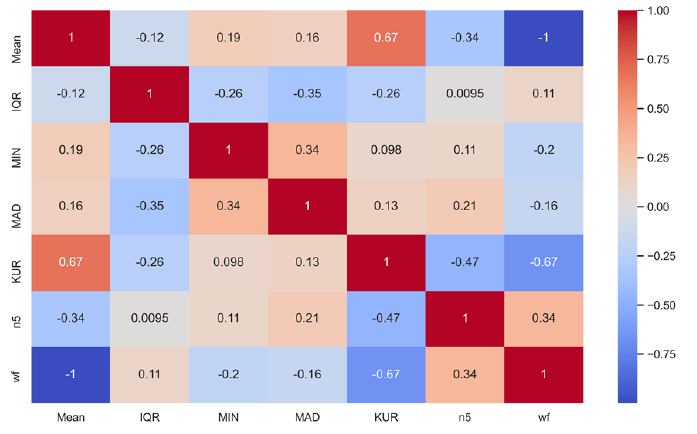
Figure 3. Correlation Matrix for all the features extracted.